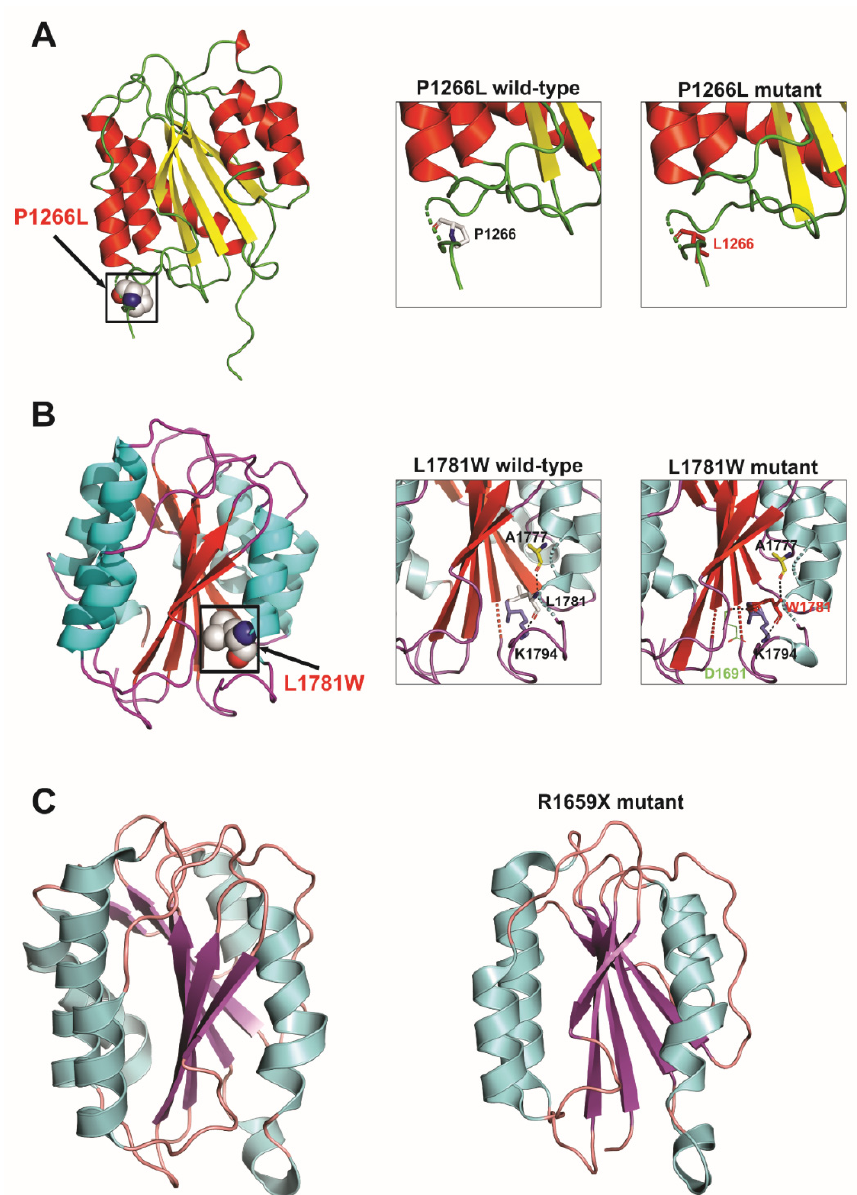
Figure 6. Cartoon representations of selected missense and truncating mutations in the VWF A1, A2 and A3 domains. ( A ) Experimentally determined 3D protein structure of human VWF A1 domain (left) and localization as well as steric encumbrance caused by the p.Pro1266Leu amino acid substitution (inserts on the right). ( B ) Ribbon diagram of the entire VWF A3 domain (left) and in small windows on the right are enlarged views of p.Leu1781Trp mutation illustrated as graphical sticks with changes in H-bonding (black dotted lines). A potential H-bond (with D1691) introduced by the presence of W1781 is highlighted. ( C ) Loss of secondary structure elements and changes in the overall 3D protein structure for truncating p.Arg1659Ter mutant are observed upon comparison of the wild-type (left) and mutant (right) VWF A2 domain protein structures. Models were obtained with PyMol Molecular Graphics System and 1AUQ (A1 domain), 1AO3 (A3 domain) and 3GXB (A2 domain) pdb files.